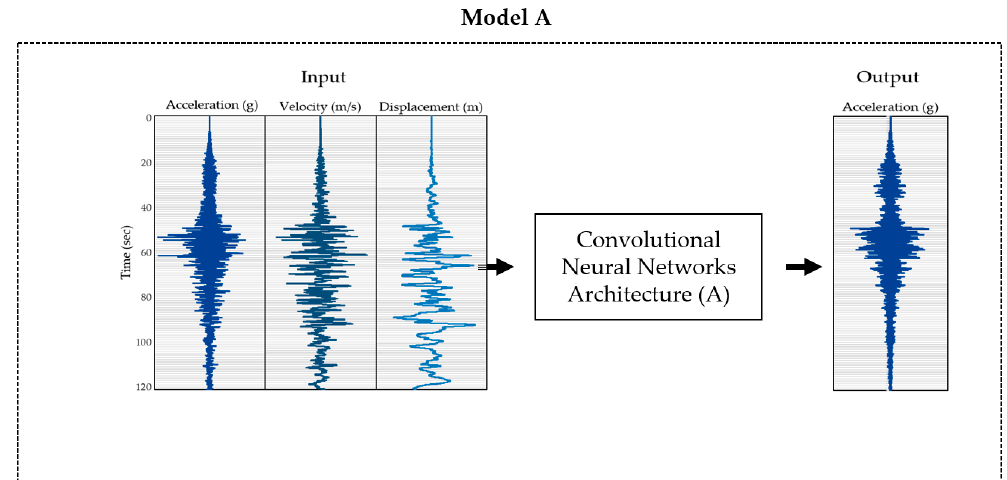
Figure 5. Overview of model A.